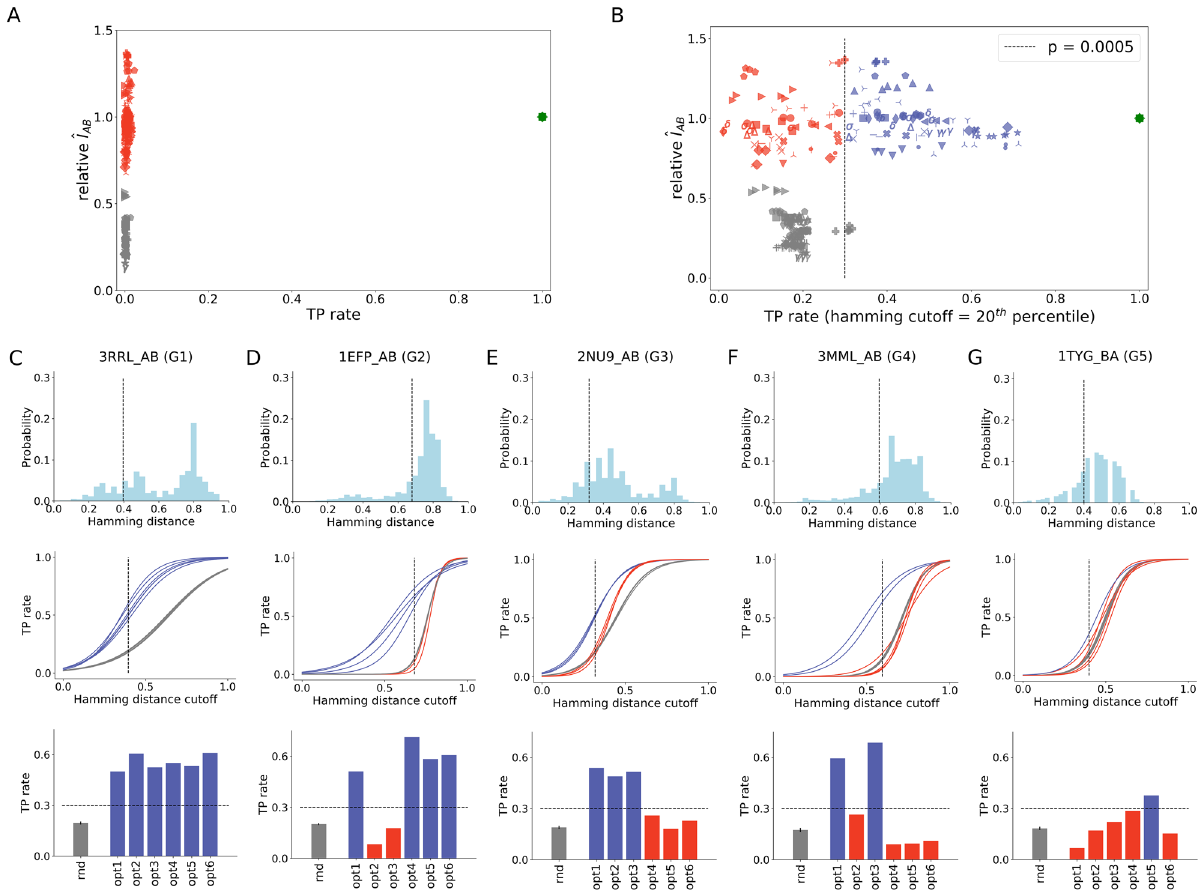
Figure 3. Evaluation of optimized MSA concatenations. ( A ) True positive (TP) rate of random, optimized and native MSA concatenations. ( B ) Reassessed TP rate of random, optimized and native MSA concatenations by discounting wrong pairings among sequences with Hamming distance within the 20th percentile of the distance distribution. Optimized solutions with TP rate greater than 30% (p = 0.0005) are shown in blue, while optimized solutions with TP rate lower than 30% are shown in red. Random solutions are shown in gray. ( C – G ) Hamming distance distribution of MSA B, TP rates versus Hamming distance discounts (the 20th percentile is shown with a dashed line), and TP rates of random (rnd) and optimized (opt1–6) solutions for the 20th percentile Hamming distance cutoff shown for representative systems: 3RRL_AB ( C ), 1EFP_AB ( D ), 2NU9_AB ( E ), 3MML_AB ( F ), and 1TYG_BA ( G ). This figure was generated using matplotlib v3.1.2 (https:// matpl otlib. org/ ).